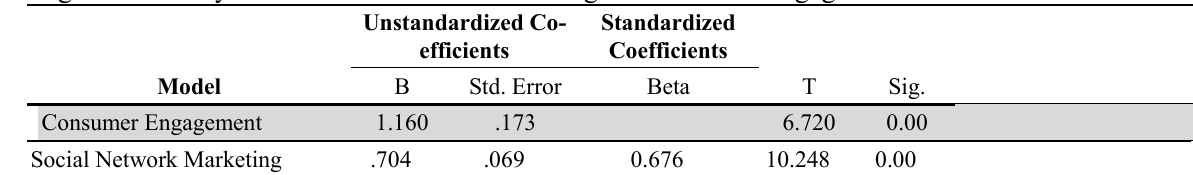
Regression Analysis of Social Network Marketing on Consumer Engagement Unstandardized Co- Standardized efficients Coefficients T Sig. B Std. Error Beta Model Consumer Engagement